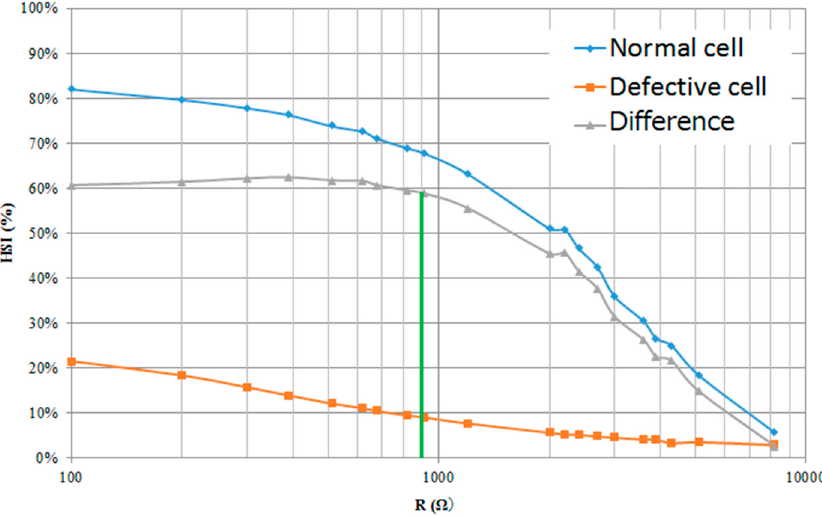
Figure 15. Correlation between HSI and Resistance at 1000 Lux, the X axis is resistance of insertion resistor and the Y axis is hot-spot risk factor HSI .